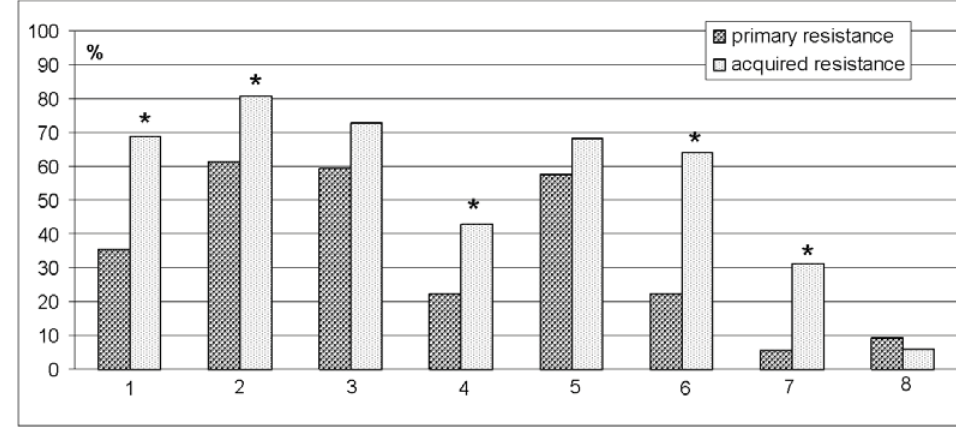
Figure 1. Level of primary and acquired drug-resistance in M.tuberculosis .